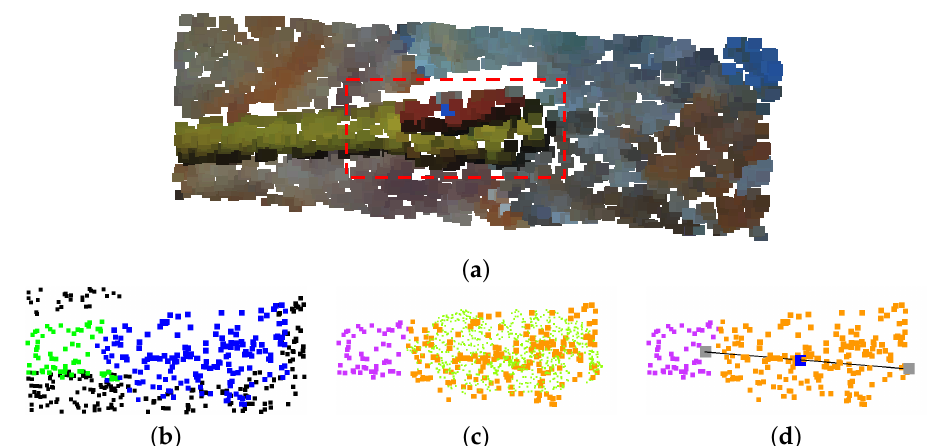
Figure 7. Valve information extraction process: ( a ) Original point cloud (area of interest highlighted in red square); ( b ) Deep neural network segmentation; ( c ) Instance clustering and best valve model registration (light green points); ( d ) Instance clustering along resulting valve central point (blue point) and vector (black line between the two gray points).